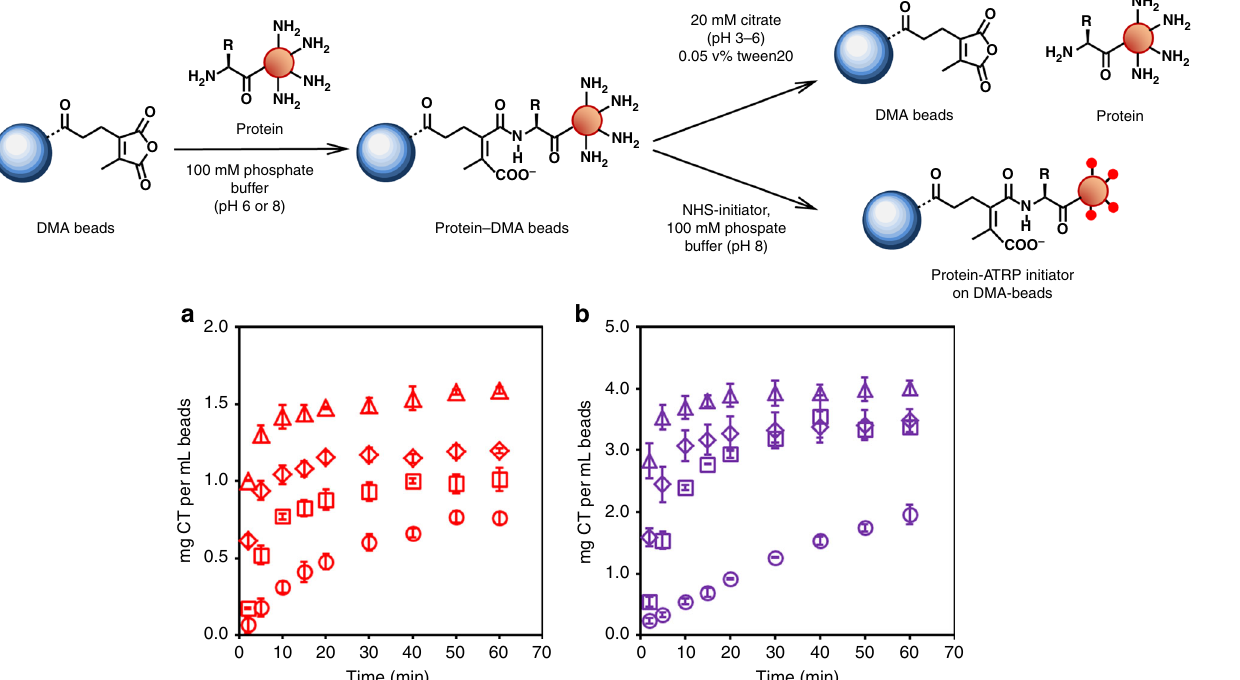
Fig. 2 Reversible protein immobilization to DMA – agarose beads and ATRP initiator modi fi cation. a Chymotrypsin release kinetics as a function of pH (3 – 6) after initial immobilization at pH 6.0 (red, determined by microBCA protein assay) and b after initial immobilization at pH 8.0 (purple, determined by microBCA assay). In both plots, release was performed by incubation at pH 3 (open triangle), pH 4 (open diamond), pH 5 (open square), and pH 6 (open circle). The amount of recoverable protein and release rate increased as pH decreased. Error bars represent standard deviation from triplicate measurements